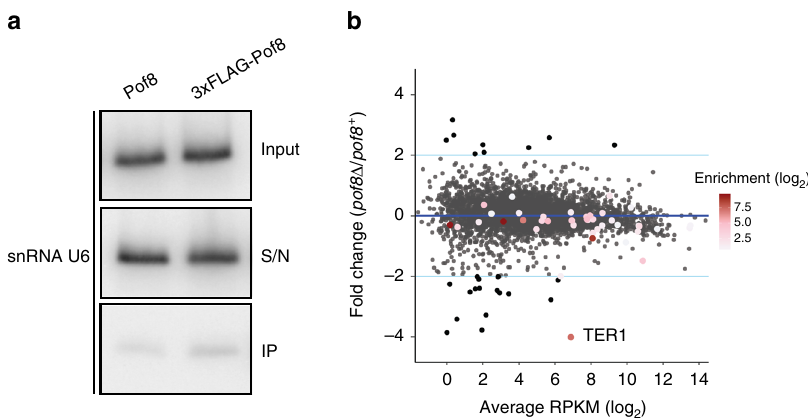
Fig. 7 Pof8 is not a general loading factor for Lsm2-8. a Northern blot for U6 snRNA from input (10%), supernatant (S/N, 10%), and immunoprecipitates (IP, 100%) with anti-FLAG from extracts of cells expressing untagged or FLAG epitope-tagged Pof8. b Scatter plot relating changes in gene expression upon deletion of pof8 to enrichment of RNAs in Lsm8 immunoprecipitate. Gene expression in log 2 average RPKM is plotted on the x -axis and the log 2 fold change between pof8 Δ and wildtype on the y -axis. Differentially expressed genes with an absolute log 2 fold change of ≥ 1 and an adjusted p -value < 0.05 are colored black. Genes that are enriched in the Lsm8 IP are colored by log 2 (Lsm8 IP/Control IP) as indicated by the color gradient in the